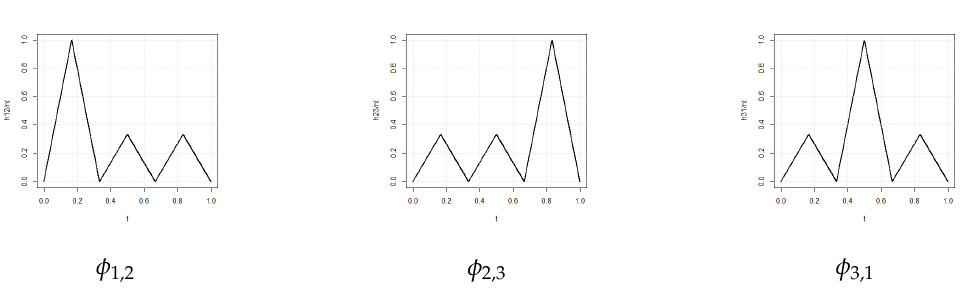
Figure 8. Comparison between pairs of